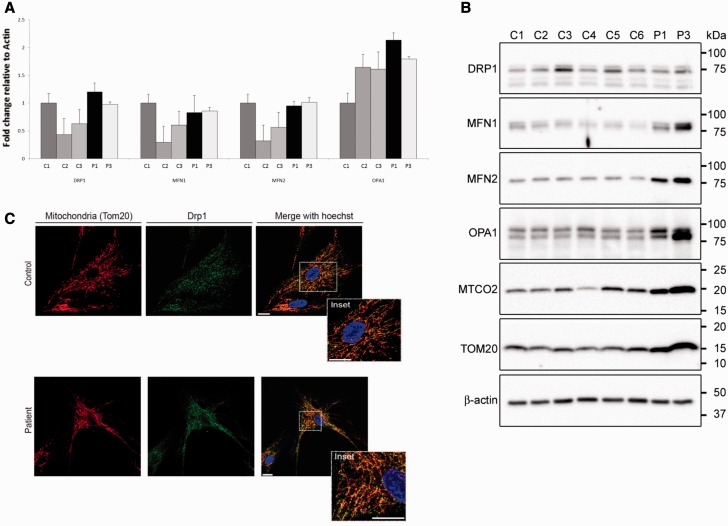

Transcript and protein expression of fission and fusion proteins and DRP1 localization. (A) Quantitative PCR analysis of DRP1, MFN1, MFN2 and OPA1 in three controls (C1–C3) and two patients (Patients 1 and 3). The samples were normalized to C1 and ACTB encoding β-actin was used as an endogenous control (n = 3). (B) Western blot analyses of 14 μg protein extracted with 1.5% n-dodecyl-β-d-maltoside from control (C1–6) and patient (Patients 1 and 3) fibroblast cultures. Blots were probed with antibodies raised against DRP1, MFN1, MFN2, OPA1, MTCO2 and TOM20 as indicated. An antibody raised against β-actin served as loading control. (C) DRP1 localization was carried out by labelling the mitochondria with TOM20, DRP1 with FITC conjugated secondary antibody and nuclei with Hoechst and visualized under a confocal microscope. Overlaid images show DRP1 co-localization with TOM20 on the mitochondria.